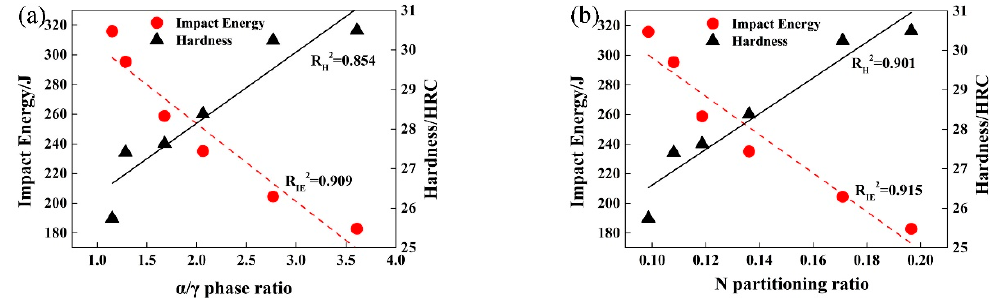
Figure 13. ( a ) Effect of α / γ phase ratio on impact energy and hardness; ( b ) effect of N partitioning ratio on impact energy and hardness.